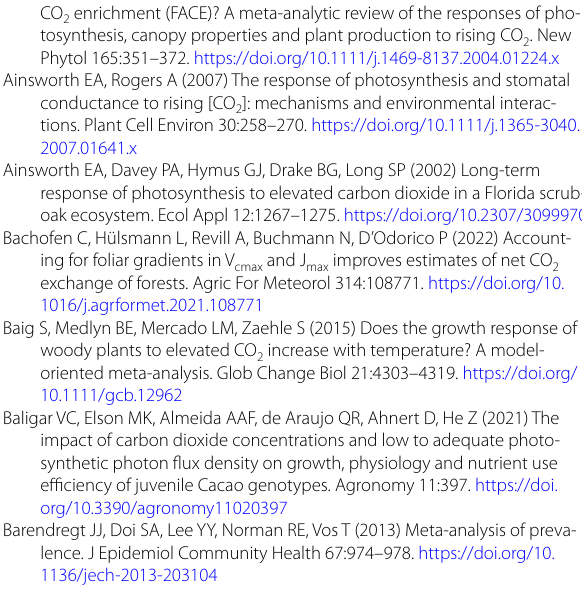
S6 . Percentage change ( 95% CI) in leaf N and C:N of woody plants with ± different N-fixation ability (a, d and g), leaf phenology (b, e and h) and leaf types (c, f and i) grown at eCO 2 . The whiskers denote 95% CI and the circles denote mean percentage change. The numbers above the major ticks of the X -axis denote number of observations. Key to leaf types: Compound-small compound leaves with small leaflets and Needle- = like needle-like leaves. Fig. S 7 . Leaf area index (A) and total biomass (B) = of woody plants grown at eCO 2 . RR response ratio. The grey dots indi- = cate the data points or observations and the black square is the mean RR. Fig. S8 . Shoot (A) and root biomass (B) of woody plants grown at eCO 2 . RR response ratio. The grey dots indicate the data points or observations = and the black square is the mean RR. Fig. S9. Shoot height (A) and specific leaf area (B) of woody plants grown at eCO 2 . RR response ratio. The grey = dots indicate the data points or observations and the black square is the mean RR. Fig. S10 . Light saturated photosynthesis ( A max ) of woody plants grown at eCO 2 . RR response ratio. The grey dots indicate the data points = or observations and the black square is the mean RR. Fig. S11. Photo- synthetic carboxylation of Rubisco ( V cmax ; A) and electron transport rate ( J max ; B) of woody plants grown at eCO 2 . RR response ratio. The grey dots = indicate the data points or observations and the black square is the mean RR. Fig. S12. Leaf N (A) and C:N ratio (B) of woody plants grown at eCO 2 . RR response ratio. The grey dots indicate the data points or observations = and the black square is the mean RR. Fig. S13 . Stomatal conductance ( g s ) of woody plants grown at eCO 2 . RR response ratio. The grey dots = indicate the data points or observations and the black square is the mean RR. Fig. S14: Transpiration (Tr; A) and water use efficiency (WUE; B) of woody plants grown at eCO 2 . RR response ratio. The grey dots indicate = the data points or observations and the black square is the mean RR. Fig. S15 . Density plots indicating data dispersion of biomass (A), growth (B), photosynthetic (C) and water related parameters of woody plants grown at eCO 2 . RR response ratio. Fig. S16. The experimental length (days) of = woody plant exposure to eCO 2 for biomass assessment. The violin india- cates the distribution of data. The bold horizontal line denotes a median time and the black square inside the box denotes mean ( X ) duration of the exposure to eCO 2 . The upper and lower vertical whiskers are 25th and 75th quartiles, respectively. The upper and lower edges of the box denote maximum and minimum duration (days) of woody plant exposure to eCO 2 . Fig. S17. Length (days) of woody plant exposure to eCO 2 for assess- ment of leaf area index (LAI), specific leaf area (SLA) and shoot height (SH). The violin indiacates the distribution of data. The bold horizontal line denotes a median duration and the black square inside the box plots denotes mean ( X ) duration of the exposure to eCO 2 . The upper and lower vertical whiskers are 25th and 75th quartiles, respectively. The upper and lower edges of the box denote maximum and minimum duration (days) of woody plant exposure to eCO 2 . Fig. S18. Length (days) of woody plant exposure to eCO 2 for assessment of stomatal conductance ( g s ), transpiration (Tr) and water use efficiency (WUE). The violin indiacates the distribution of data. The bold horizontal line denotes a median duration and the black square inside the box plots denotes mean ( X ) durationof the exposure to eCO 2 . The upper and lower vertical whiskers are 25th and 75th quartiles, respectively. The upper and lower edges of the box denote maximum and minimum duration (days) of woody plant exposure to eCO 2 . Fig. S19. Length (days) of woody plant exposure to eCO 2 for assessment of light saturated photosynthesis ( A max ), carboxylation of Rubisco ( V cmax ) and electron transport rate ( J max ). The violin indiacates the distribution of data. The bold horizontal line denotes a median duration and the black square inside the box plots denotes mean ( X ) duration of the exposure to eCO 2 . The upper and lower vertical whiskers are 25th and 75th quartiles, respectively. The upper and lower edges of the box denote maximum and minimum duration (days) of woody plant exposure to eCO 2 . Dots indicate outlier observations. The few extreme outliers (mostly studies spanning over 5 years) were removed from the graphs. Fig. S20. Length (days) of woody plant exposure to eCO 2 for assessment of leaf N and C:N ratio. The violin indiacates the distribution of data. The bold hori- zontal line denotes a median durationand the black square inside the box plots denotes mean ( X ) duration of the exposure to eCO 2 . The upper and lower vertical whiskers are 25th and 75th quartiles, respectively. The upper and lower edges of the box denote maximum and minimum duration (days) of woody plant exposure to eCO 2